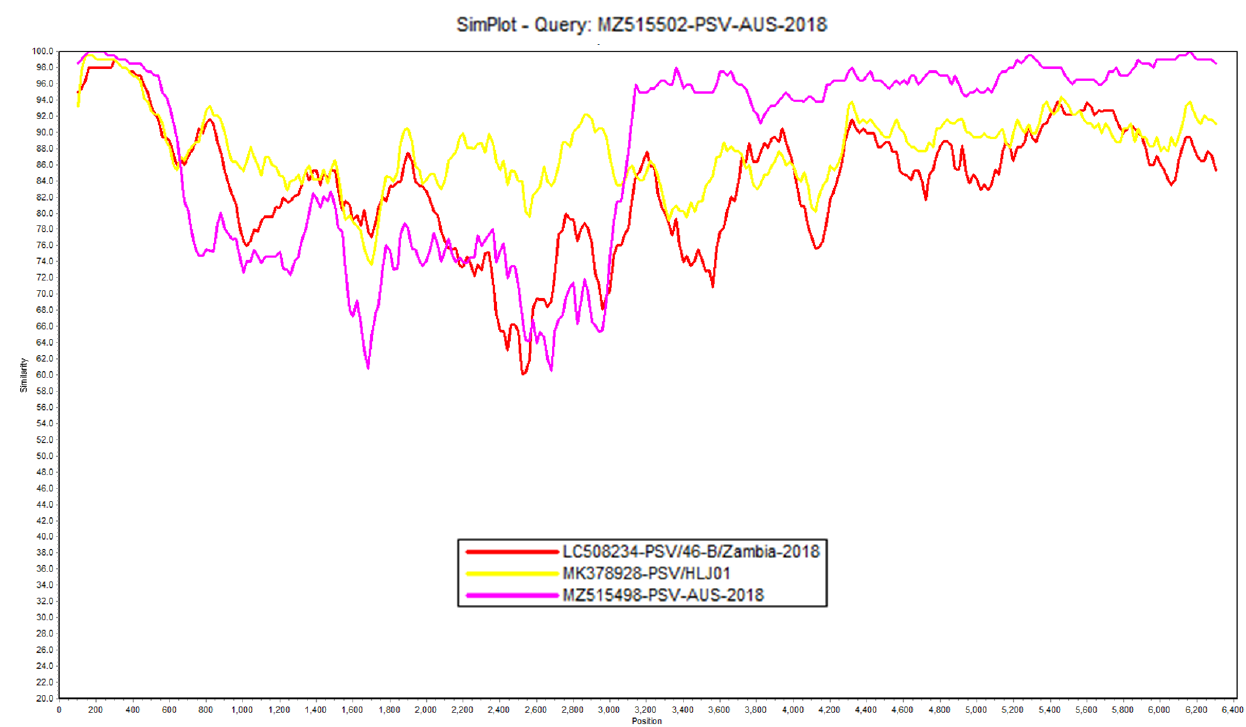
Figure 1. Similarity plot generated in SimPlot using the sequence MZ515502-PSV-AUS-2018 (Pig 46 Colon) as the query sequence against three other sequences using a 200 nucleotide sliding window at 20 nucleotide intervals and the F84 distance [64] model with the maximum likelihood method. Percentage identities at each analysis point were plotted on a line chart. For similarity plot analysis, the y -axis shows the percentage similarity between the reference sequences and the query sequence. Different colours are indexed for different reference sequences.